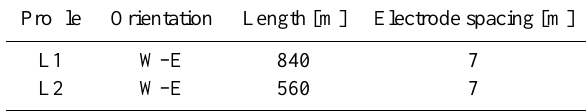
Table 3. Specifications of the ERT